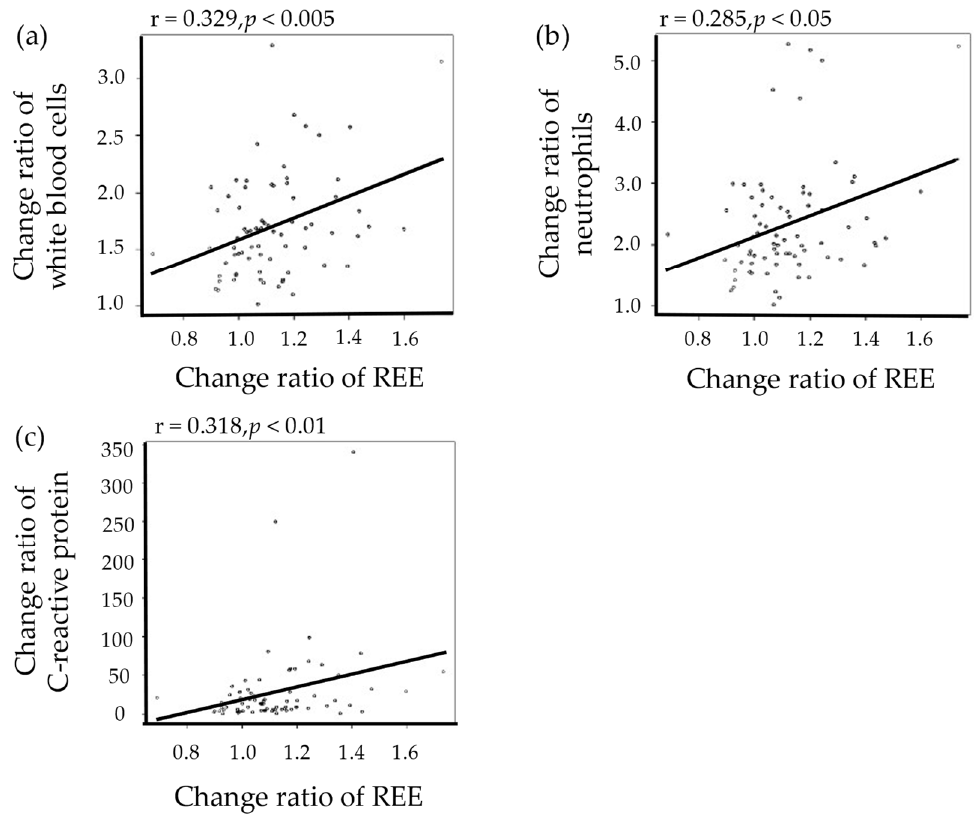
Figure 3. Correlations between the change ratios of REE and laboratory findings. ( a ) White blood cells. ( b ) Neutrophils. ( c ) C-reactive protein. REE: resting energy expenditure.